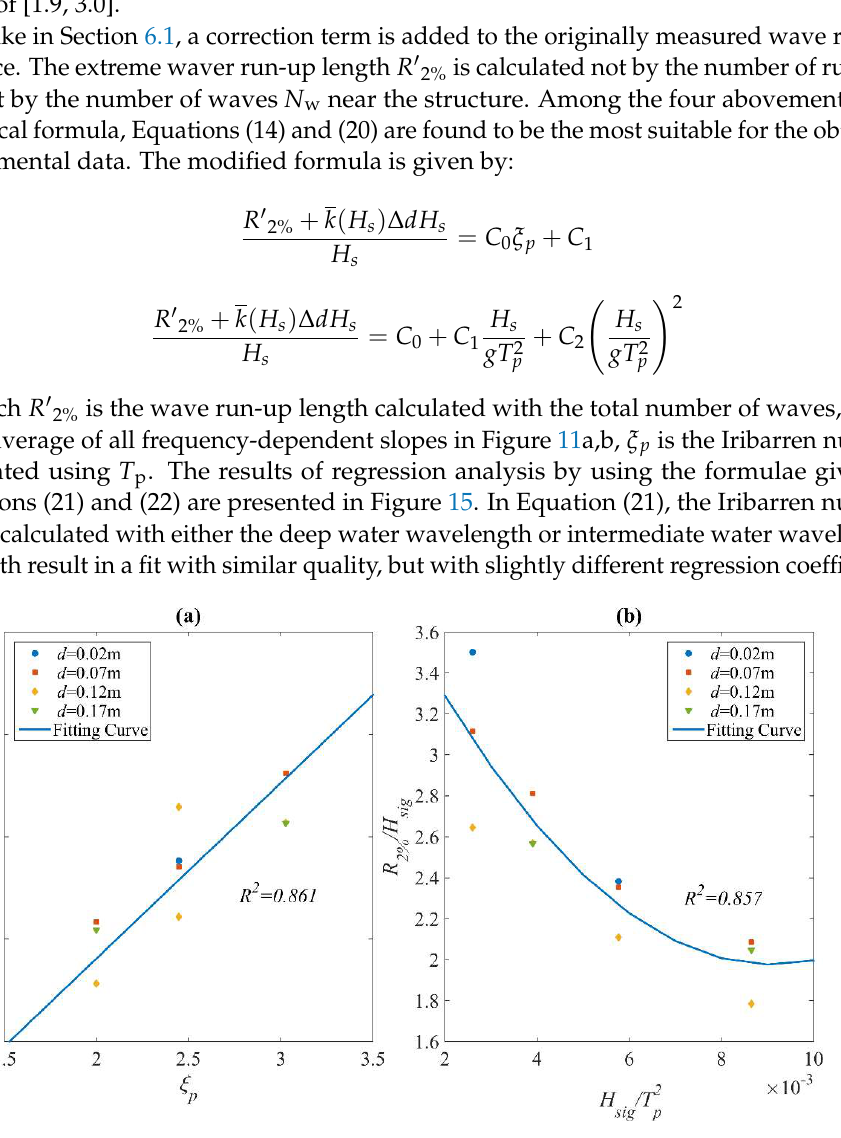
Figure 15. ( a ) Linear (Equation (21)) and ( b ) nonlinear (Equation (22)) regression models of extreme wave